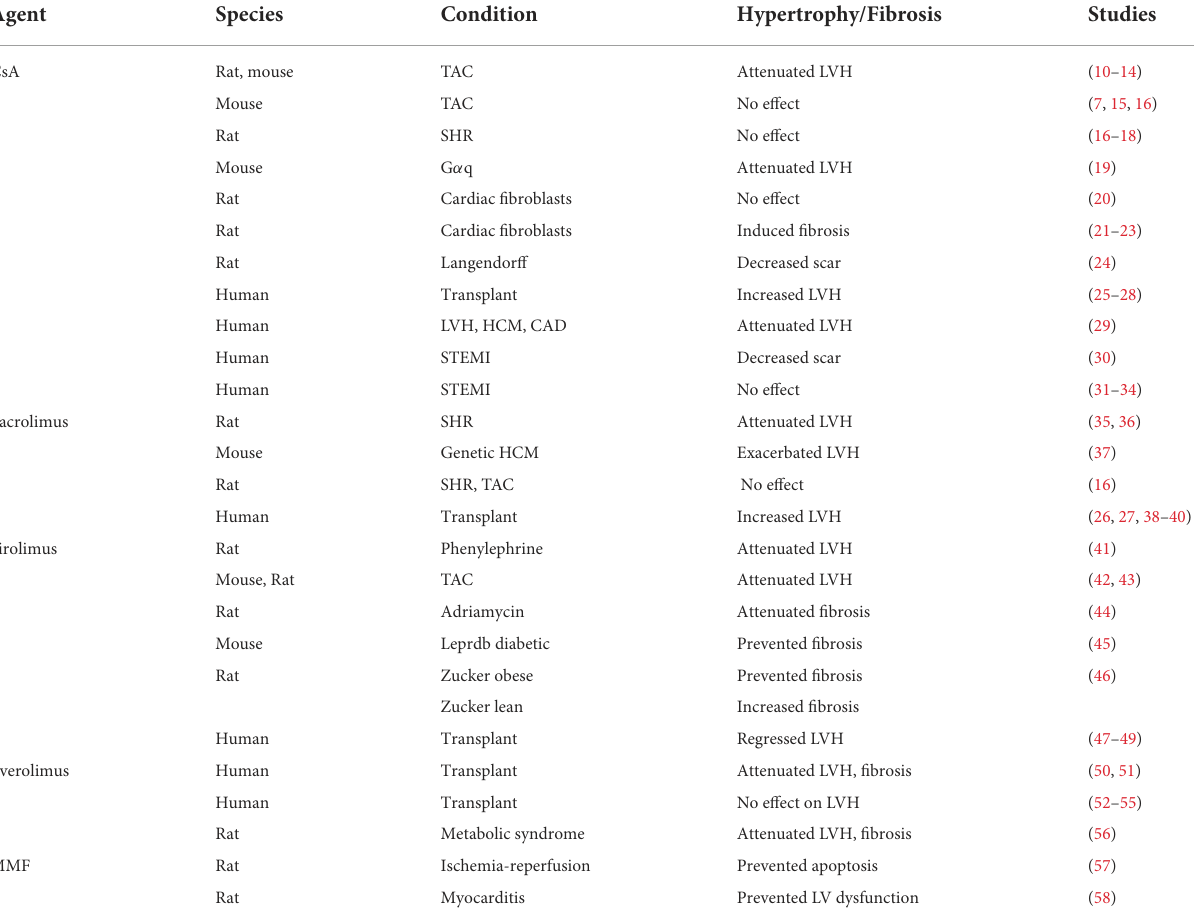
TABLE 1 Studies examining effects of immunosuppression on cardiac hypertrophy and